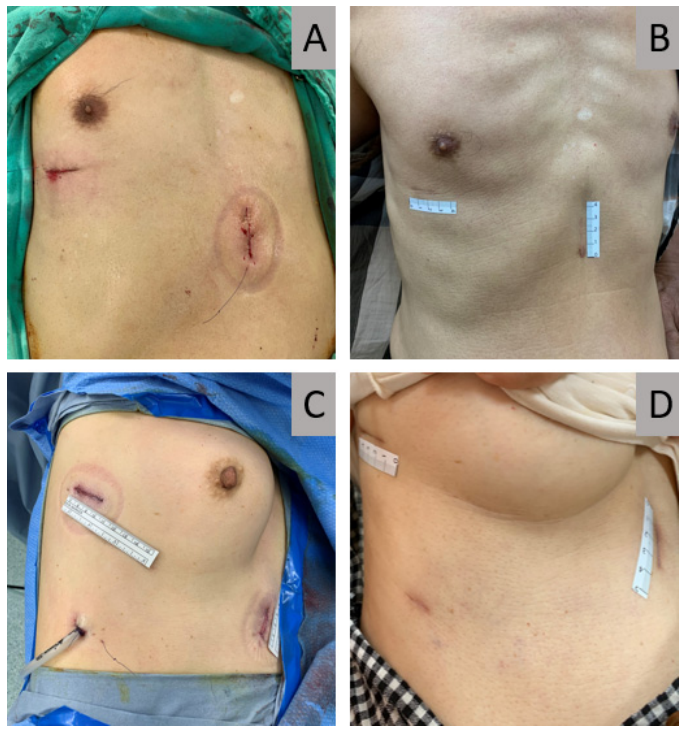
Figure 6. Patients receiving multiportal subxiphoid and intercostal VATS. ( A ) A patient with ante- rior mediastinal tumor received two-port VATS resection with subxiphoid and intercostal incision with equal lengths and no postoperative drain insertion. ( B ) Postoperative picture of the above- mentioned patient 3 months following surgery. ( C ) A patient with lung cancer received 3-port VATS right lower lobectomy with subxiphoid and intercostal incisions of the same lengths and drain-in-